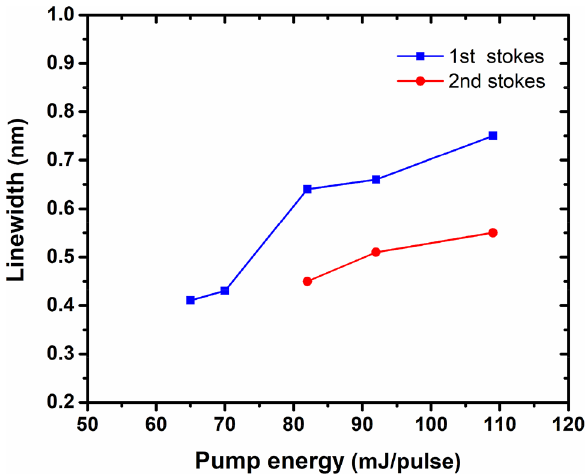
Figure 4. The linewidth (FWHM) of 1st Stokes (blue squares) and 2nd Raman Stokes (red circles) as a function of the input pump